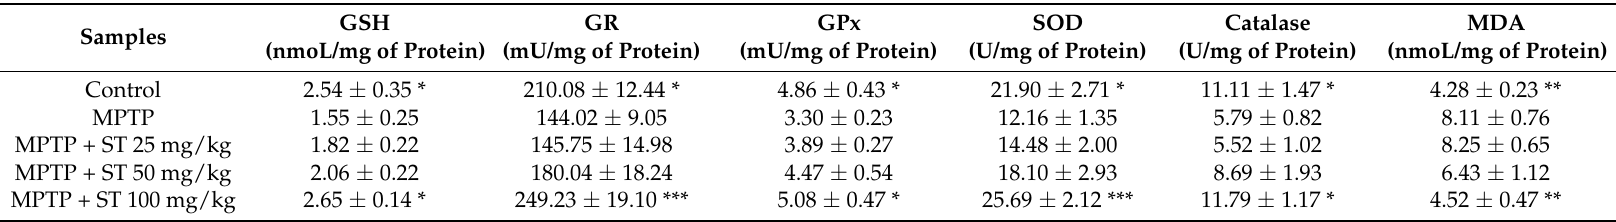
Table 1. Effects of Sophora tomentosa (25 mg/kg, 50 mg/kg, and 100 mg/kg, po) extract on the levels of glutathione and malondialdehyde, and the activities